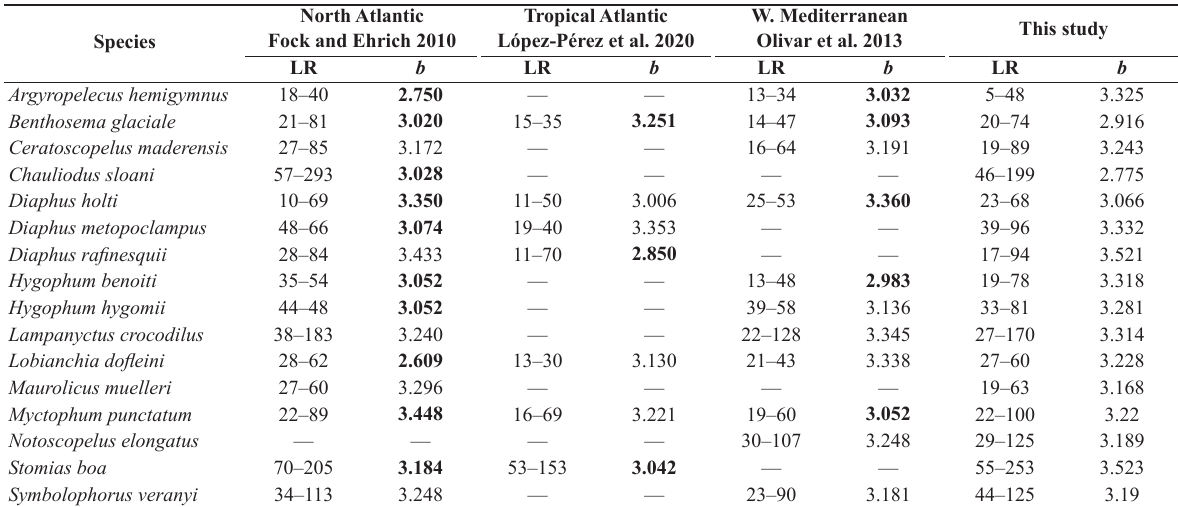
Table 2. Values of parameter b and length ranges (LR) of mesopelagic fishes from other regions.